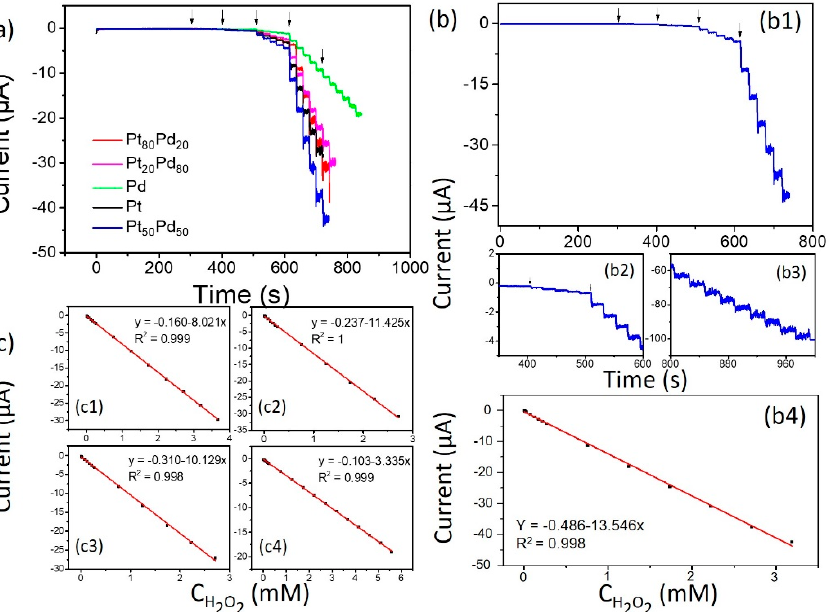
Figure 6. ( a ) Amperometric responses of the aerogel modified electrodes with successive addition of 2 × 10 − 5 M (50 µ L), 0.002 M (50 µ L), 0.02 M (50 µ L), 0.6 M (17 µ L), and 1 M (10 µ L) into 20 mL N 2 -saturated 0.1 M PBS aqueous solution at − 0.05 V. ( b ) (b1) Amperometric responses of the Pt 50 Pd 50 aerogel modified electrodes (b2,b3). Enlarged part of amperometric response of Pt 50 Pd 50 aerogel modified electrode. (b4) Calibration curve of the Pt 50 Pd 50 for H 2 O 2 RR in N 2 -saturated PBS aqueous solution. ( c ) (c1–c4) Calibration curve of Pt 20 Pd 80 , Pt 80 Pd 20 , Pt, and Pd for H 2 O 2 RR in N 2 -saturated PBS aqueous